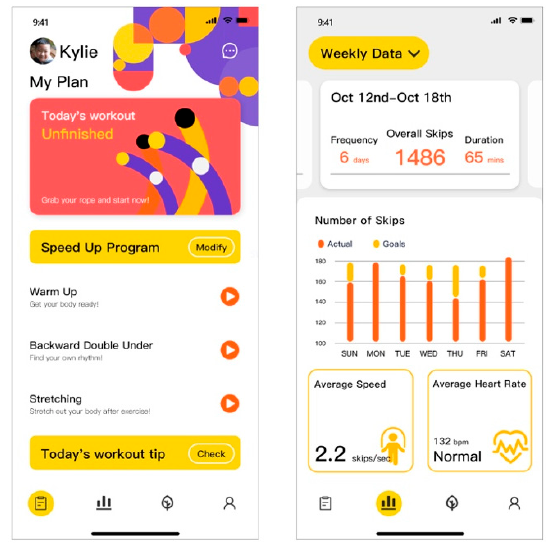
Figure 14. Optimized main interface and exercise log interface.